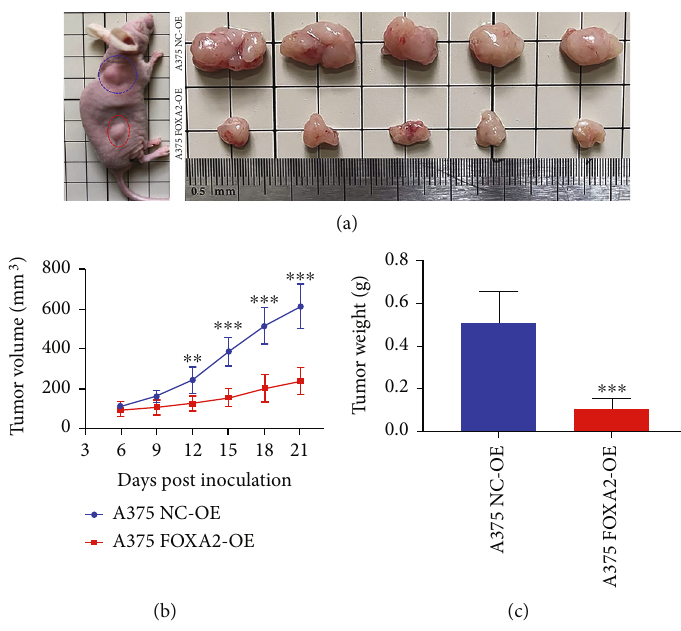
Figure 8: FOXA2 inhibits subcutaneous melanoma xenograft growth in mice. (a) Nude mice ( n = 5 ) were injected subcutaneously with A375 NC-OE and A375 FOXA2-OE melanoma cells. After 21 days, mice were sacri fi ced, and tumors were collected. (b) Tumor size was measured on di ff erent days postinjection and expressed as volume (mm 3 ) ( ∗∗ p < 0 : 01 , ∗∗∗ p < 0 : 001 vs. the control, two-way analysis of variance). (c) Tumor weights in the A375 NC-OE and A375 FOXA2-OE groups were measured after tumor samples were harvested. ∗∗∗ p < 0 : 001 vs. the control